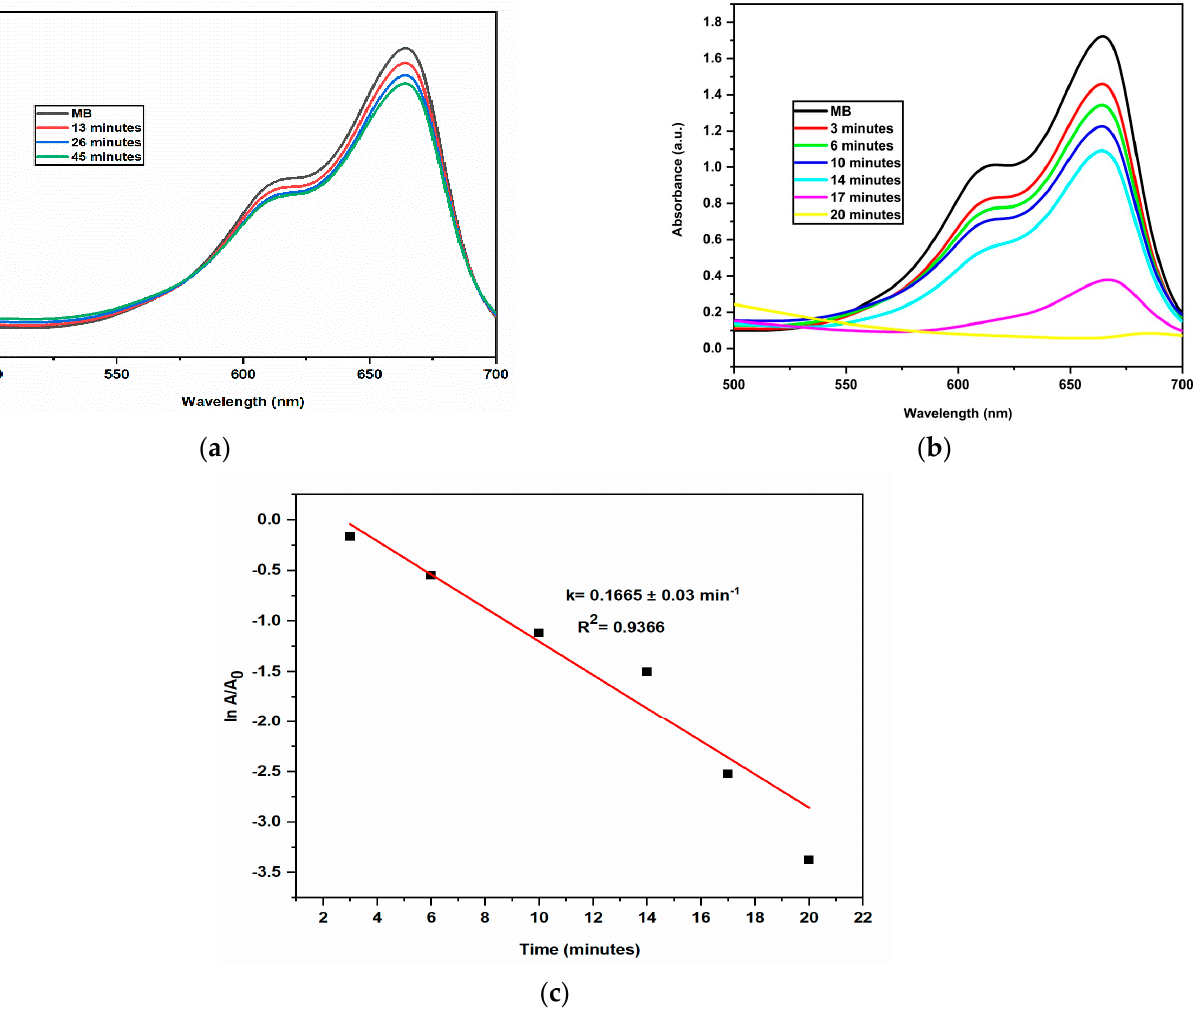
Figure 8. At 25 °C, successive UV–Vis absorbance spectra showing reduction of MB by NaBH 4 ( a ) reaction mixture without AgNPs ( b ) reaction mixture containing 0.5 mL of AgNPs ( c ) Smooth plots of ln A/A 0 versus time for the degradation of MB at 25 °C.